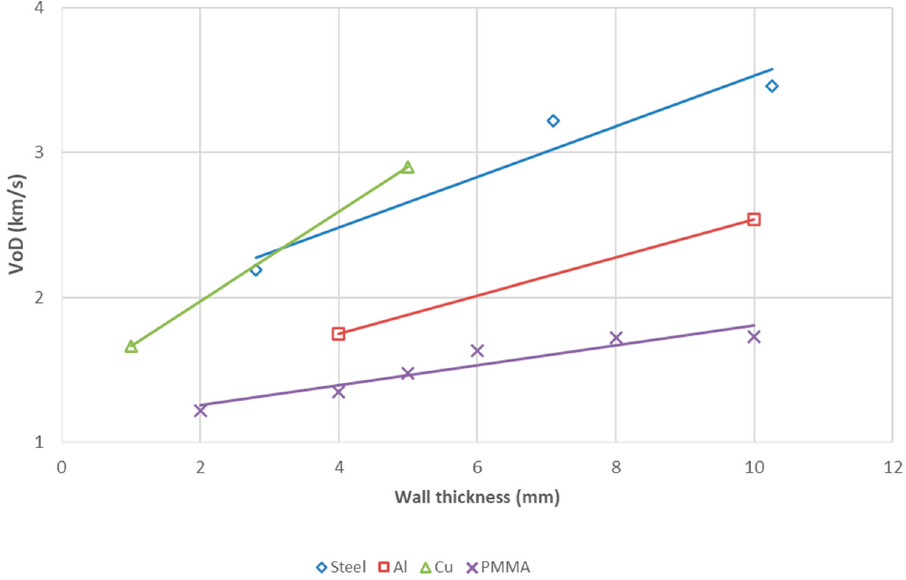
Figure 4. Influence of wall thickness on VoD.